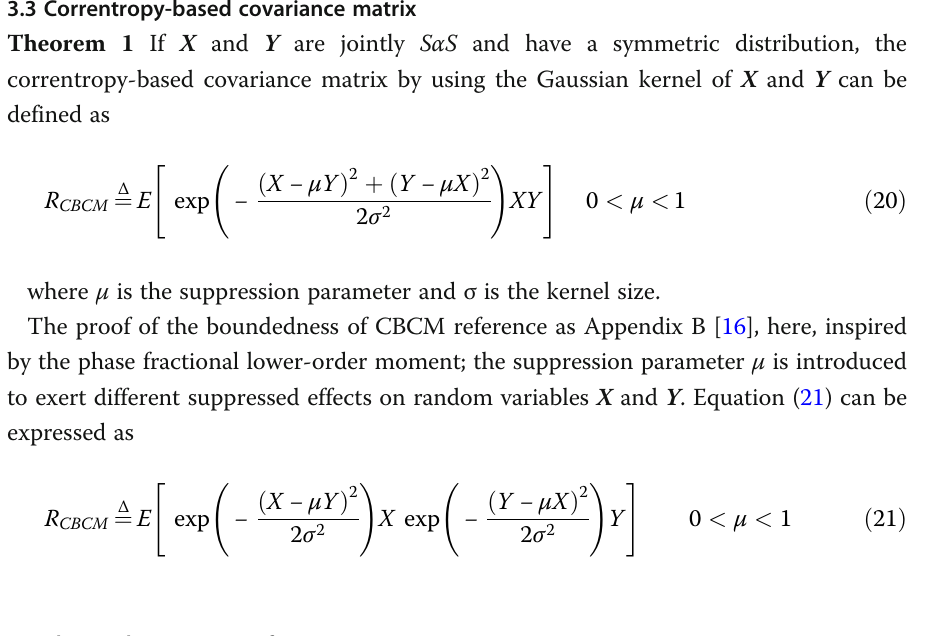
-norm, in the transition region, 2